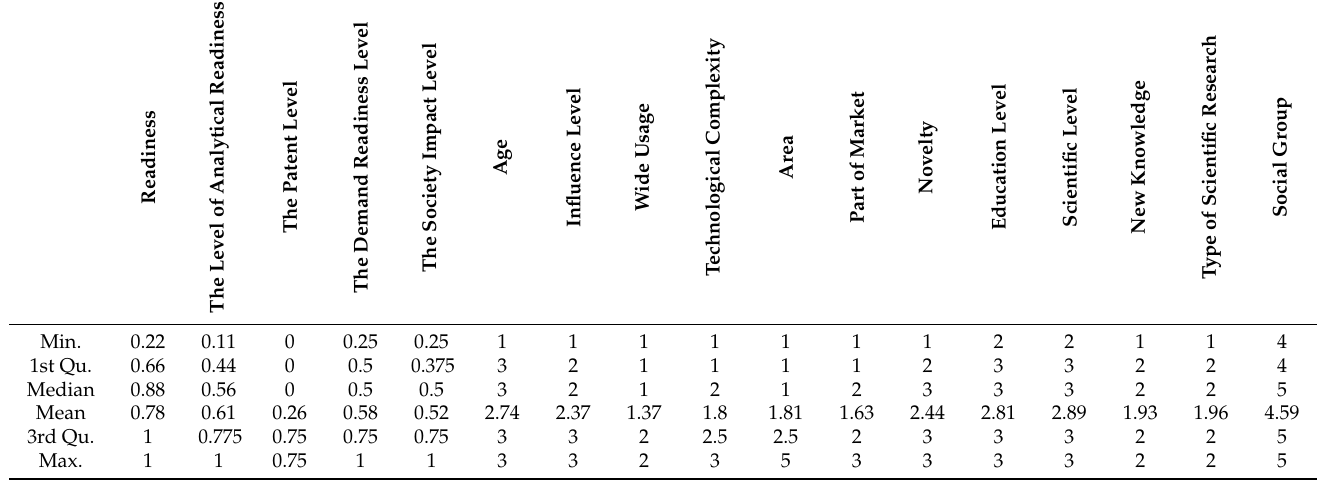
Table A1. Descriptive statistics for the dataset used for modeling.